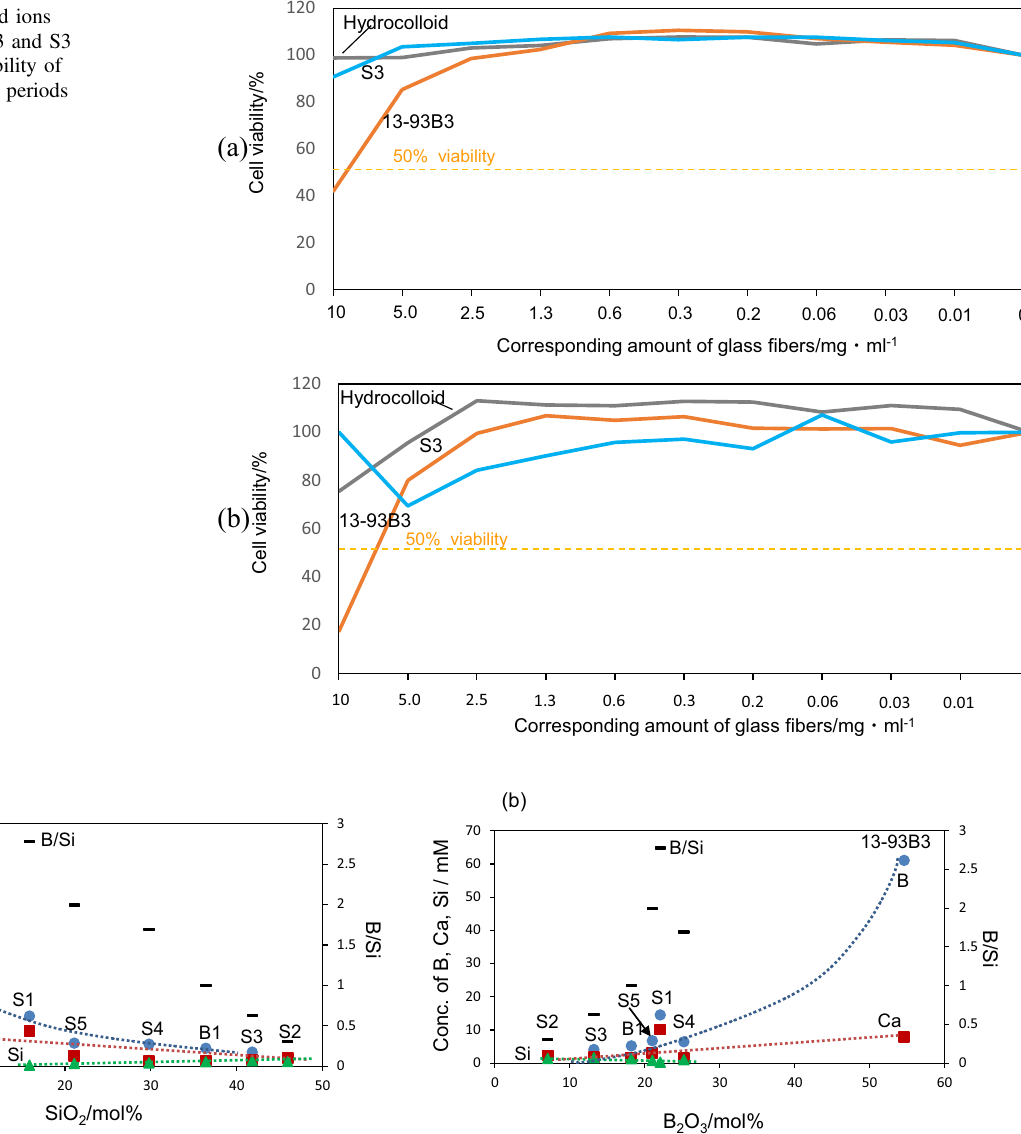
Fig. 9 Effect of released ions extracted from 13-93B3 and S3 glass fi bers on cell viability of L929 cells after culture periods of ( a ) 1 and ( b ) 3 days